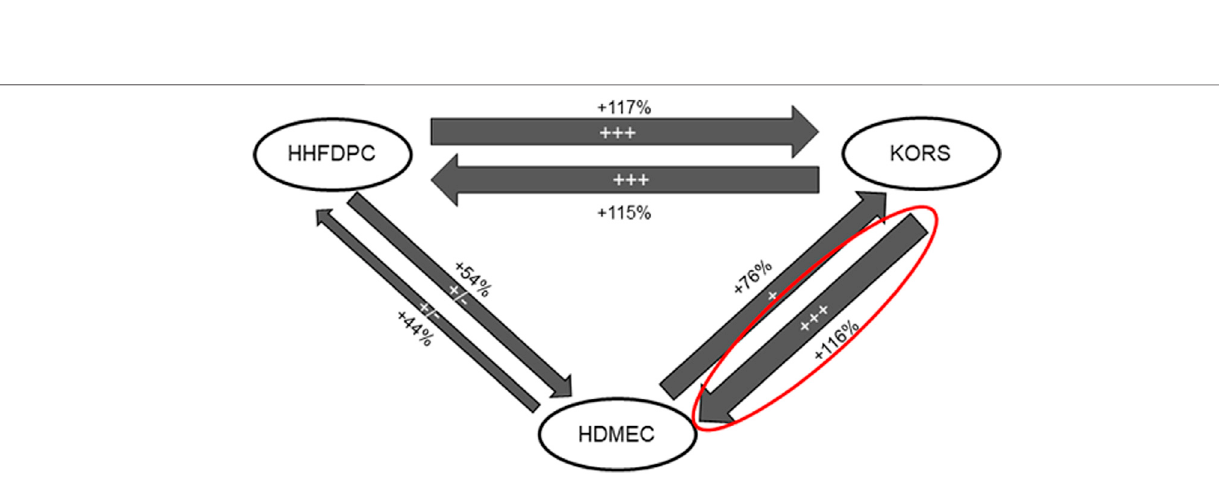
Frontiers in Cell and Developmental Biology |